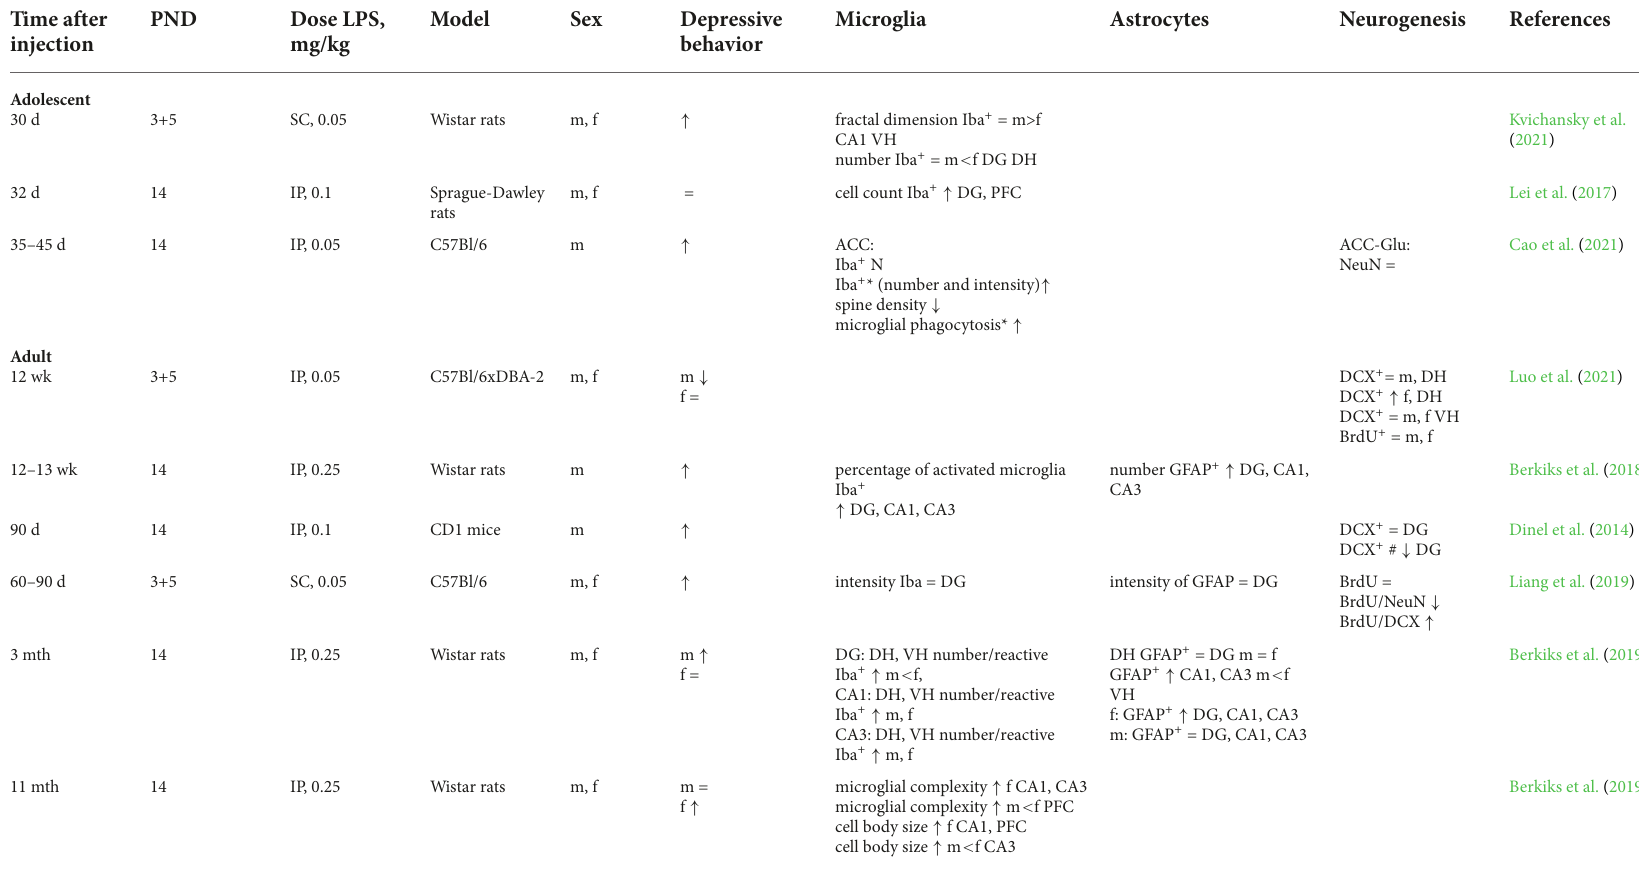
TABLE 2 Glial alterations and neurogenesis after